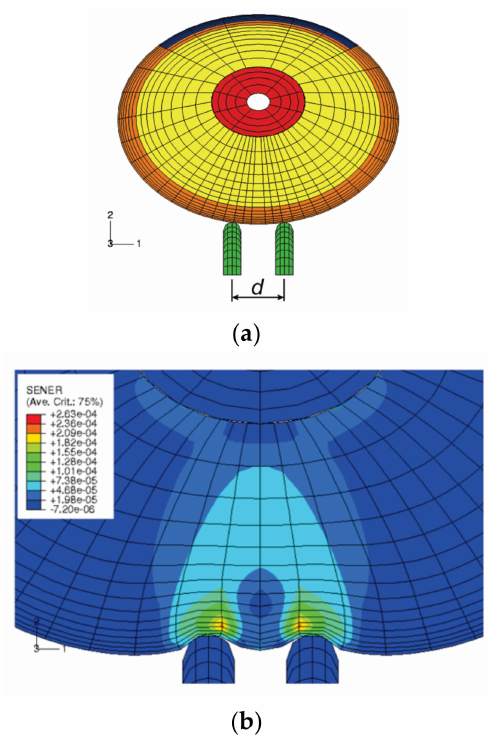
Figure 9. Finite element (FE) simulation of two-point discrimination threshold tests [125]: ( a ) FE model; ( b ) The predicted distributions of the strain energy density (SENER, mg/mm 3 ) within the soft tissues of the fingertip indented by the two probe